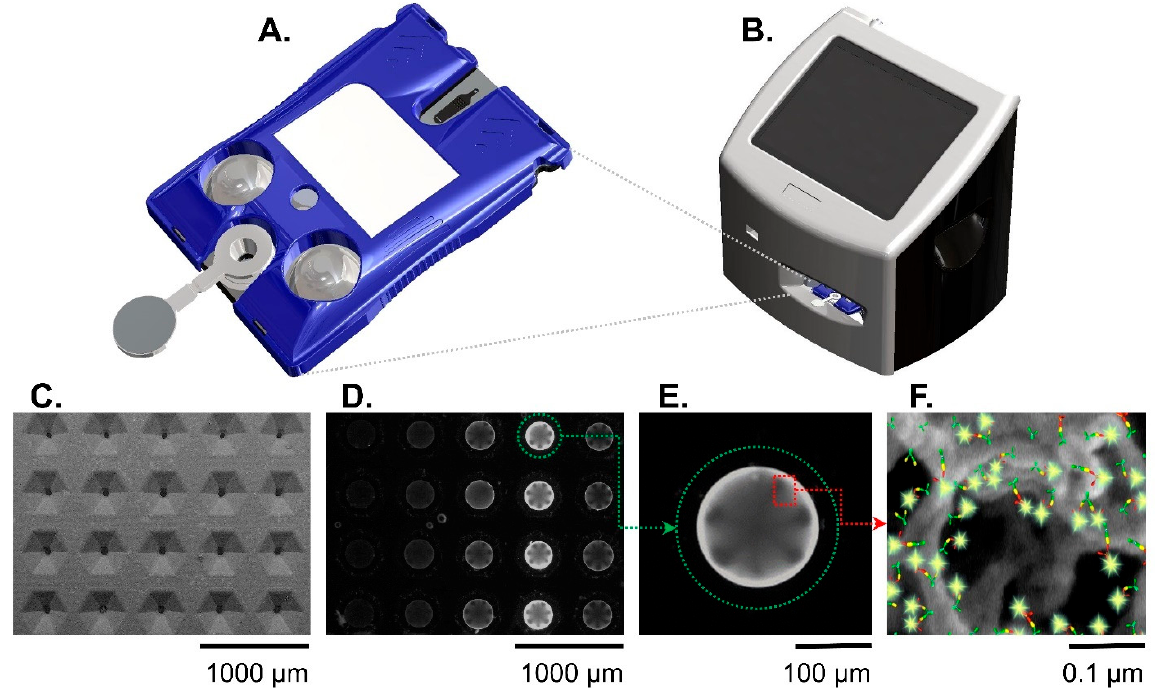
Figure 2. The Smart Immunoassay platform hardware consists of a cartridge ( A ) and a portable instrument ( B ). The instrument activates blister packs on the cartridge, performs the multistep immunoassay, and collects the immunofluorescent signal from the agarose beads. Panels ( C – F ) show the sensor(s) at different length scales. A scanning electron micrograph ( C ) shows the microfluidic cartridge’s sensor matrix without beads. A fluorescent image shows the same sensor matrix with beads present ( D ). Out of the 20 beads in the sensor matrix, a single agarose bead (encircled in green dotted line) is magnified ( E ) and shows a strong immunofluorescent reaction signal against a dark background. Panel ( F ) is a further magnified view of an agarose bead and illustration representing the fluorescent immunocomplexes formed on agarose bead fibers. The immunocomplexes are in sandwich configuration with capture antibodies (green symbols), antigen (yellow symbols), detecting antibodies (red symbols), and fluorophore (glowing yellow symbols). Reproduced from [20] with permission from the Royal Society of Chemistry.